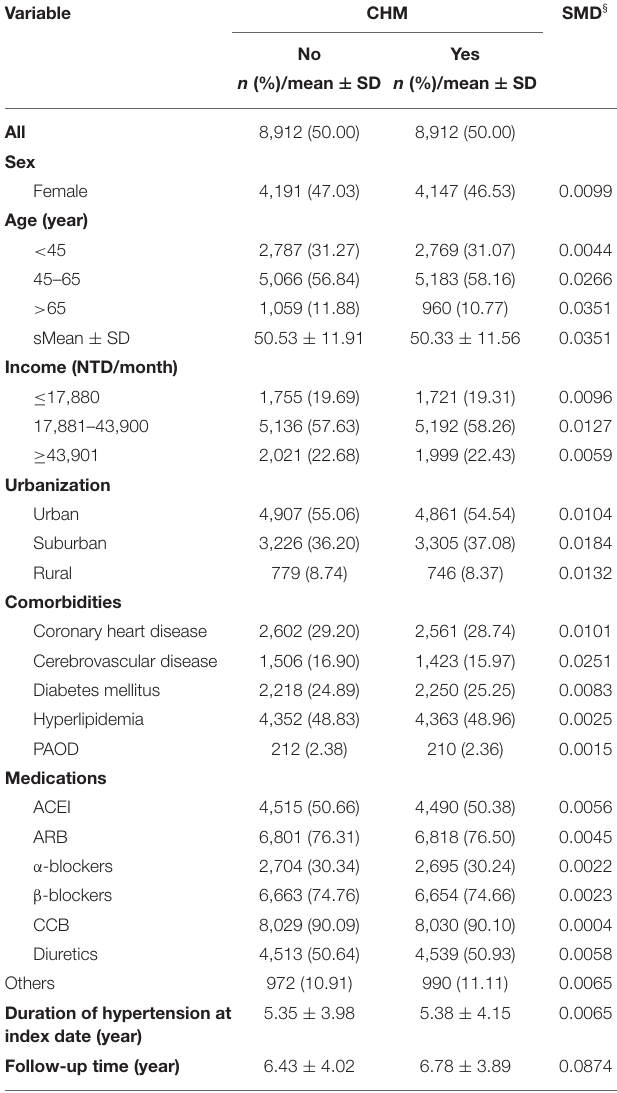
TABLE 1 | Baseline characteristics, comorbidities, and medications of hypertensive patients with and without CHM treatment. Variable